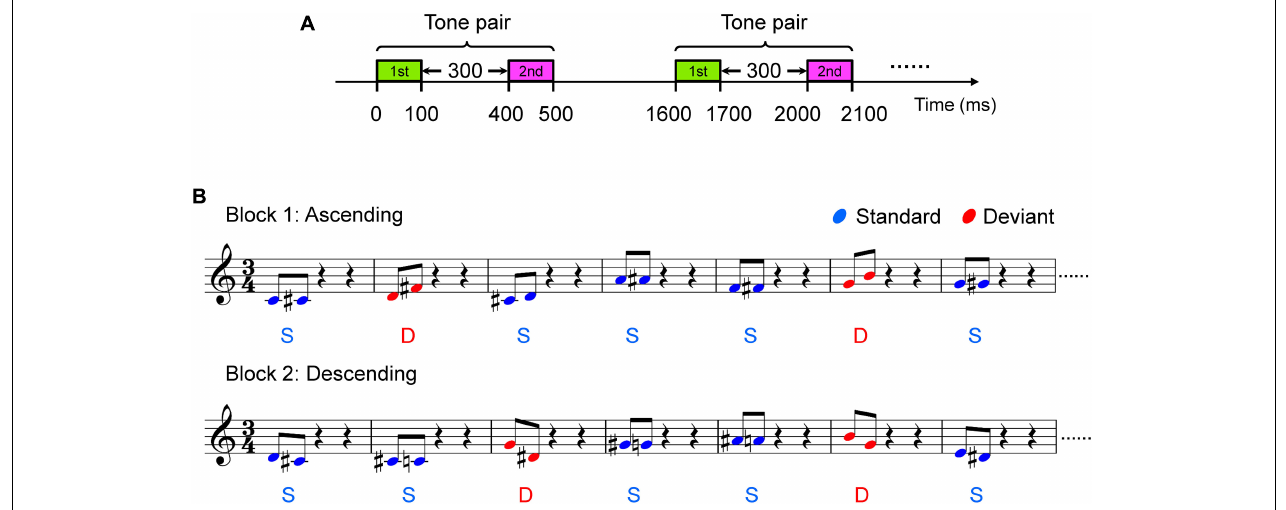
FIGURE 1 | Two blocks of oddball paradigm. (A) Illustration of tone pairs. (B) Illustration of block 1 and block 2. Sample stave for two blocks is shown. Tones in block 1 are clockwise, which means pitch of the second tone of each tone pair is always rising. Tone pairs in block 1 with shorter distance (pitch interval = one semitone, e.g. C4 – #C4) are standard stimuli and those with a larger distance (pitch interval = four semitones, e.g. C4 – E4) are the deviant stimuli. Tones in block 2 are counterclockwise, which means pitch of the following tone of each tone pair is always falling. Tone pairs in block 2 with shorter distance (pitch interval = one semitone, e.g. #C4 – C4) are standard stimuli and those with a larger distance (pitch interval = four semitones, e.g. E4 – C4) are deviant